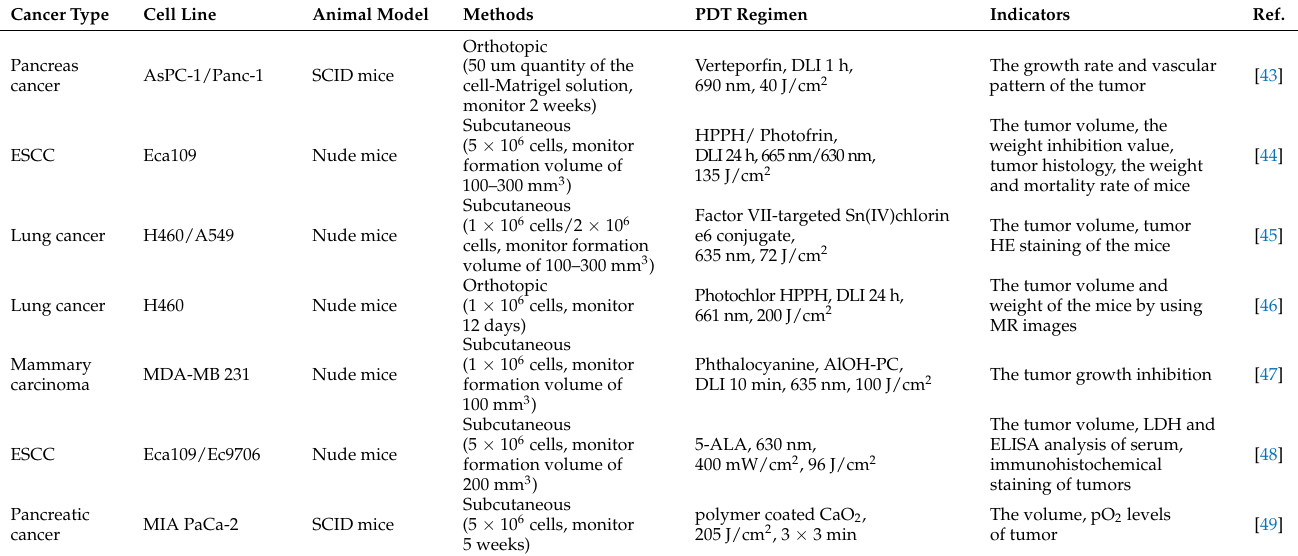
Table 2. Application of xenograft mouse in antitumor study of